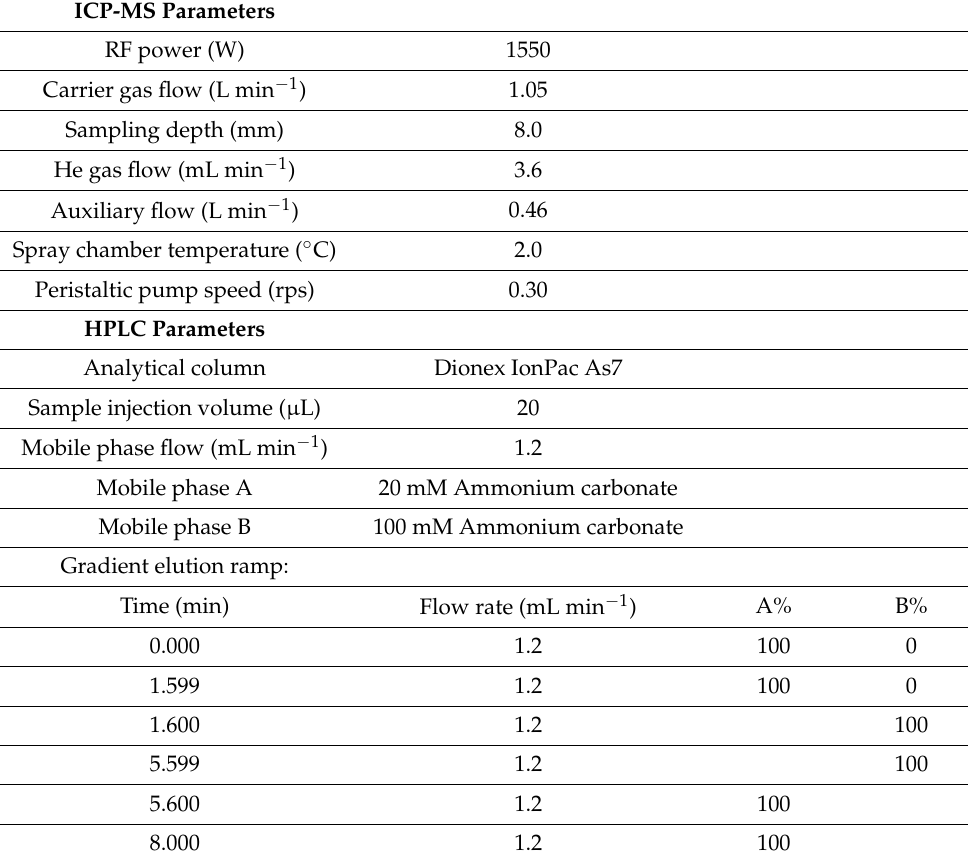
Table 4. Instrumental parameters for 75 As ICP-MS